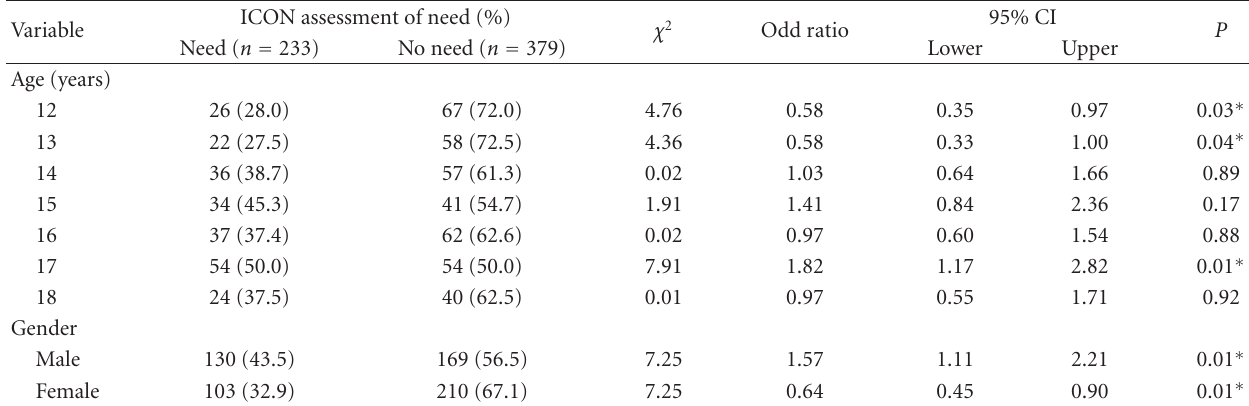
Table 2: Relationship between age, gender, and assessed orthodontic treatment need according to the Index of Complexity, Outcome, and